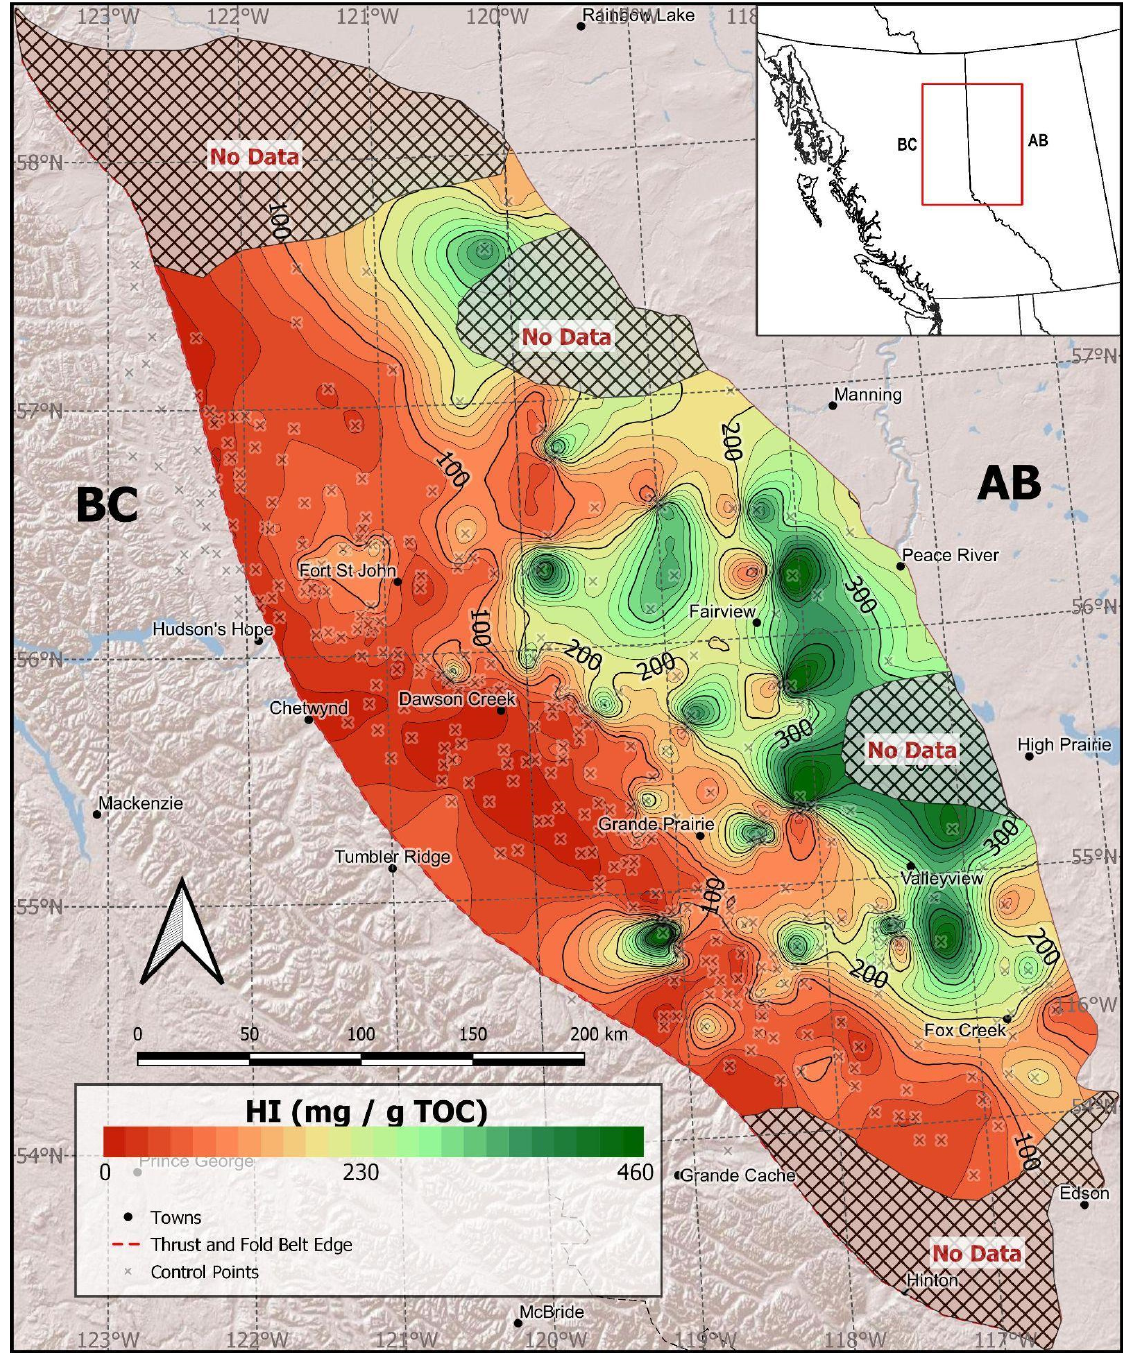
Figure 11. Distribution of hydrogen index in the Montney Formation. The HI values decrease towards the deformation front and the deeper parts of the WCSB. The decrease in HI values reflects the increase maturity of the Montney Formation as it was more deeply buried and more hydrogen is converted to hydrocarbons.